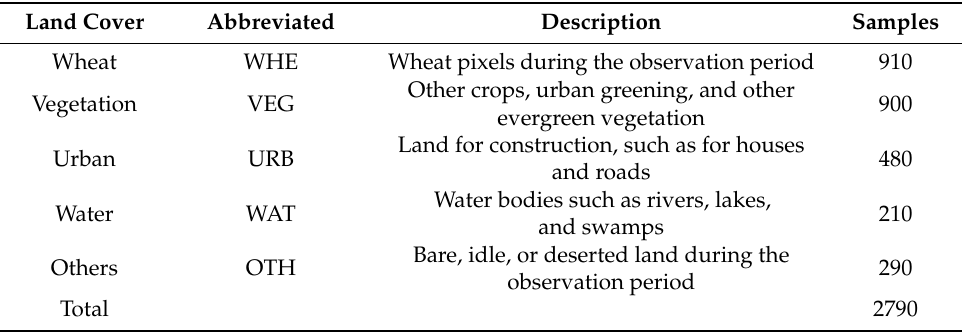
Table 2. Sample data selected in this